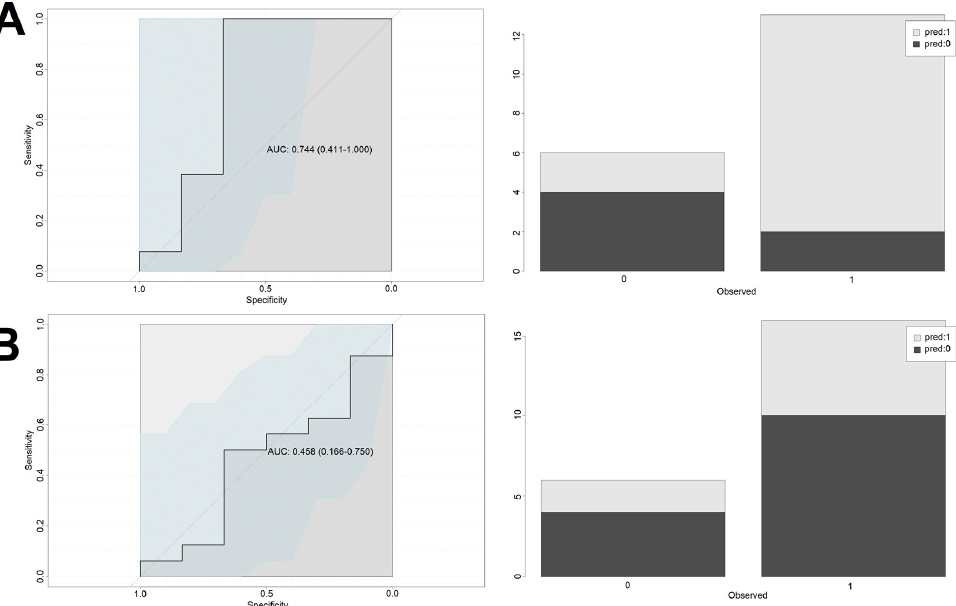
Figure 4. Performance of the cortisol-only based model on the test set. Left column depicts the ROC curves of the logistic regression models. Right column shows the accuracy of predictions on the test set based on the cut-off determined using the training set. X -axis describes the real outcomes. Colors describe the predicted outcomes. 0—Lack of endpoint fulfillment; 1—endpoint fulfillment; Y -axis depicts counts. ( A ) NGCG group. ( B ) GCG group.